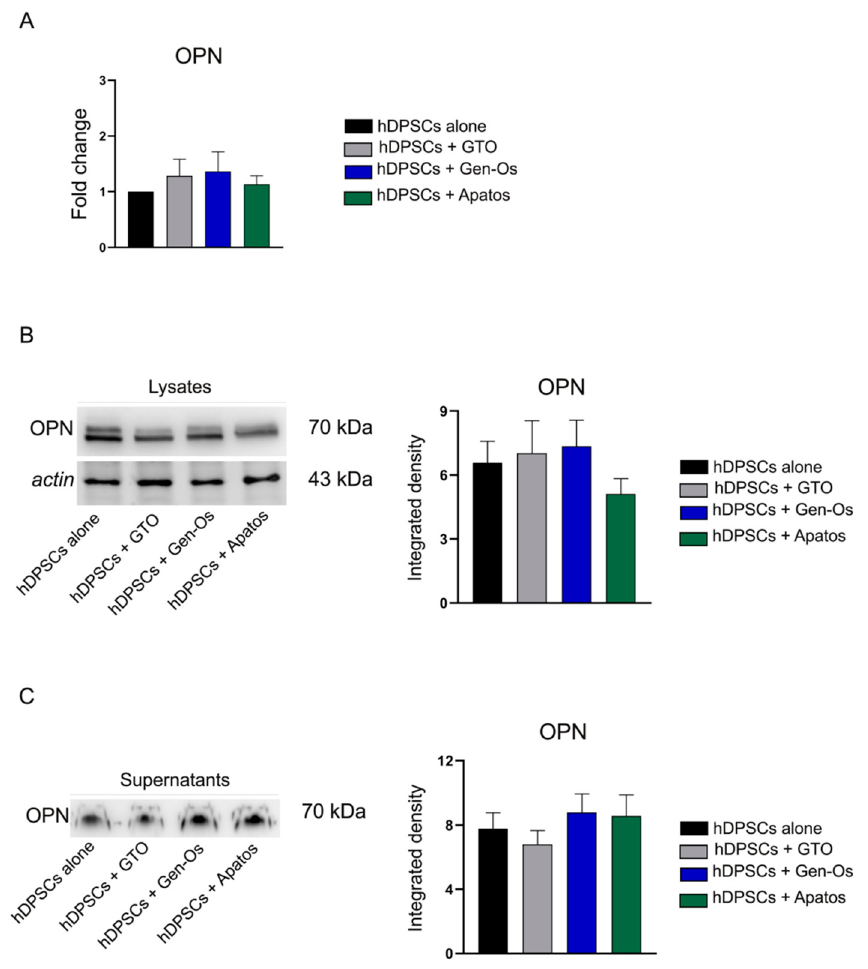
Figure 5. Assessment of OPN expression in hDPSCs following BSB treatment. ( A ) Evaluation of OPN expression by real-time PCR analysis reveals that OPN mRNA levels are higher in treated samples than hDPSCs alone. ( B ) Western blot analysis of OPN performed on whole lysates of BSB-treated hDPSCs shows no statistical differences among the experimental groups. ( C ) The release of OPN in cell culture media by hDPSCs is detected through Western blot analysis on supernatants of each experimental group (50 µ L). Histograms show that OPN-secreted form is observed in BSB-treated hDPSCs, as well as in the control group, without any statistically significant differences.